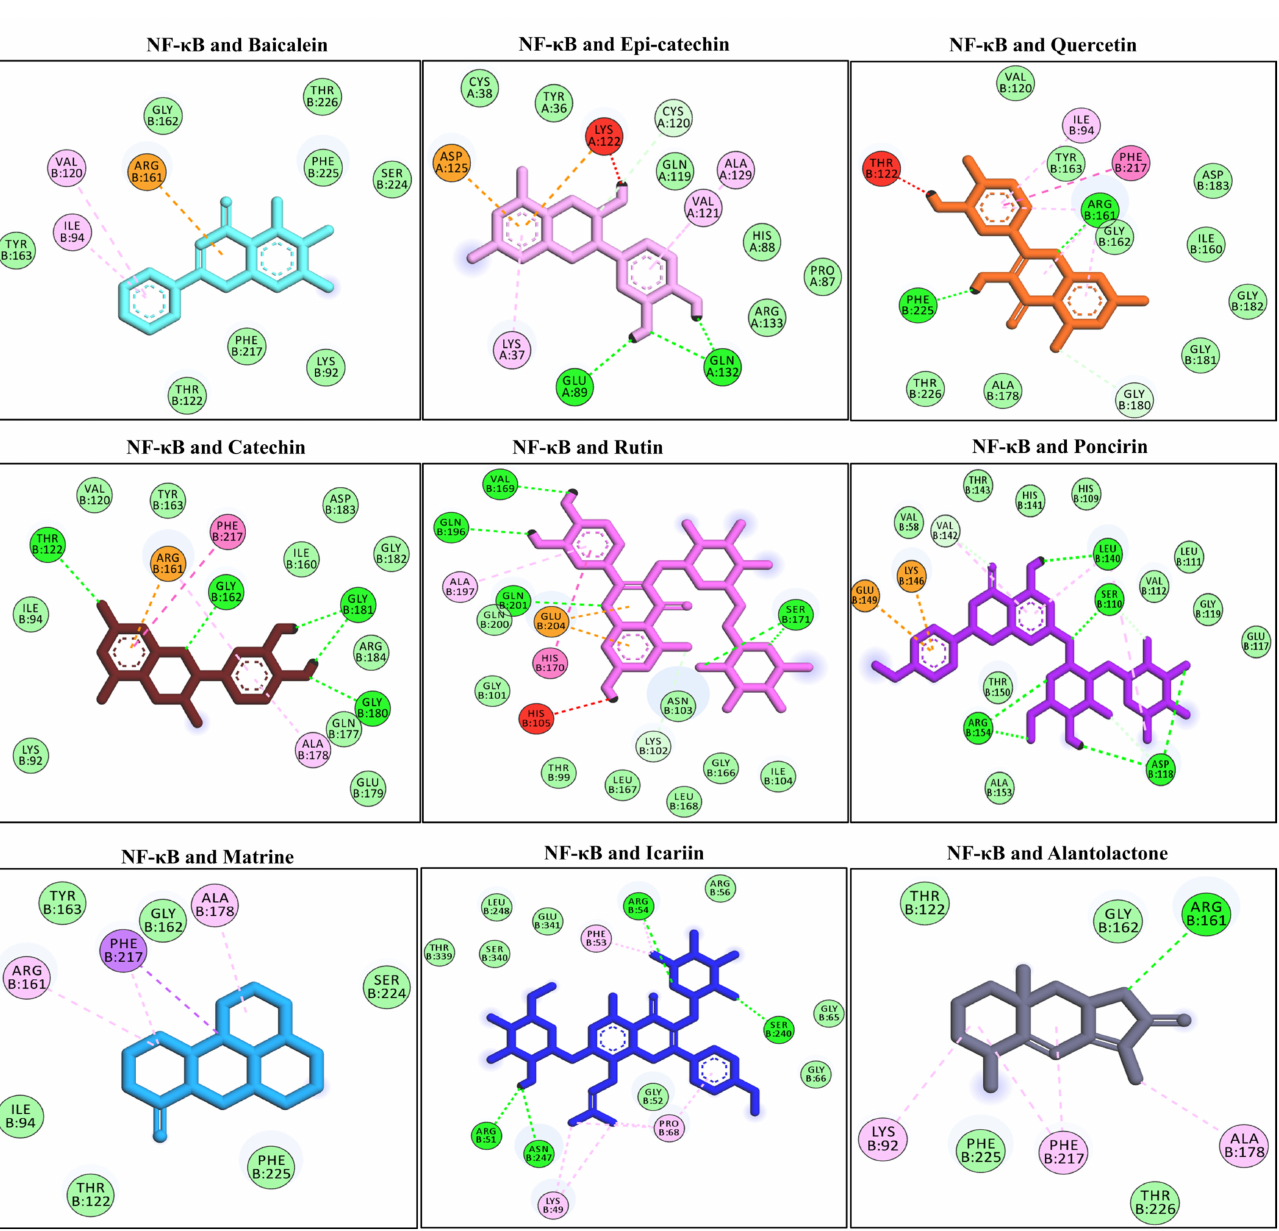
Figure 5. The molecular docking analysis of the selected compounds with the NF- κ B receptor using AutoDock Vina software. The molecular docking showed binding of the studied ligand with the NF- κ B via multiple hydrophilic and hydrophobic bonds. The ligand and protein interactions were visualized in Discovery Studio Visualizer_16 and ligands whose negative binding energy was high were